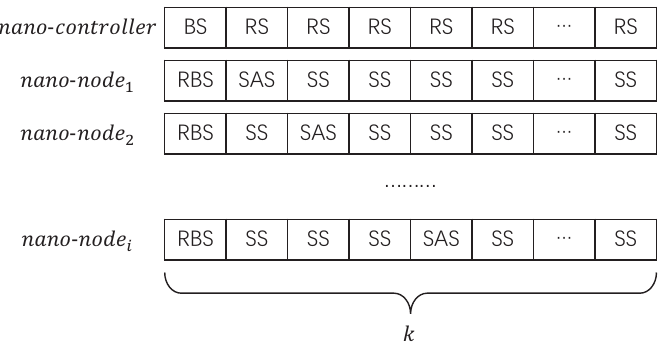
Figure 4. An example of time slots division and allocation in